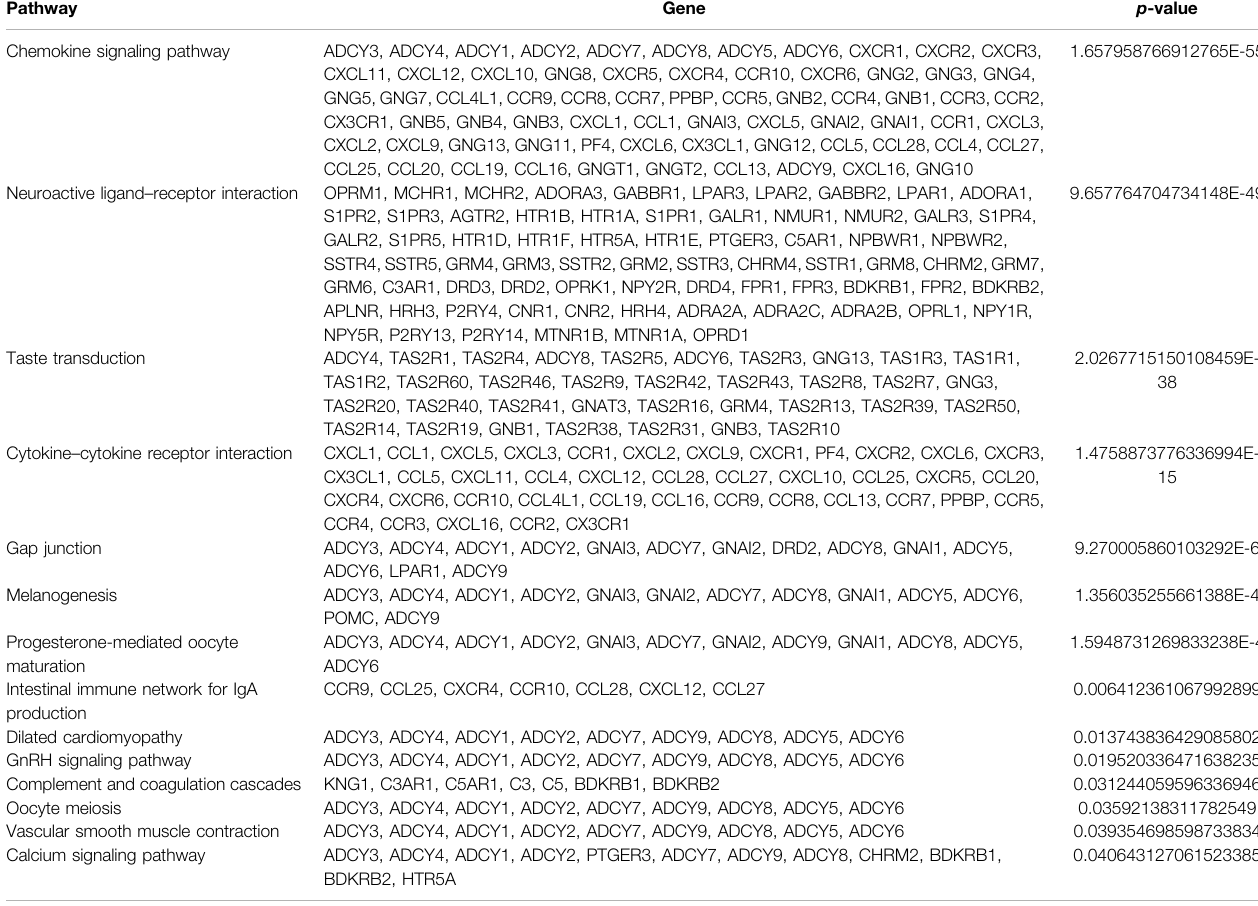
TABLE 2 | The pathway of module 1.